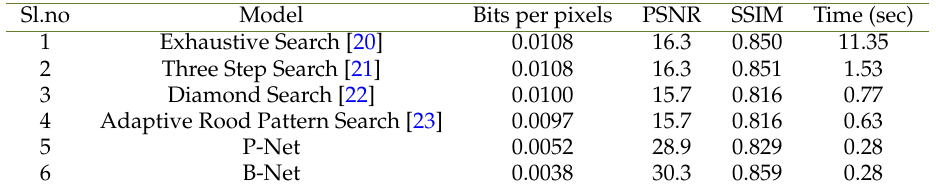
Fig. 8. Comparison graph of PSNR and SSIM for B-net with existing techniques. Table 2. Motion compensation value for macroblock split16x16 with pixel around the block as 7 for16 frame video prediction.